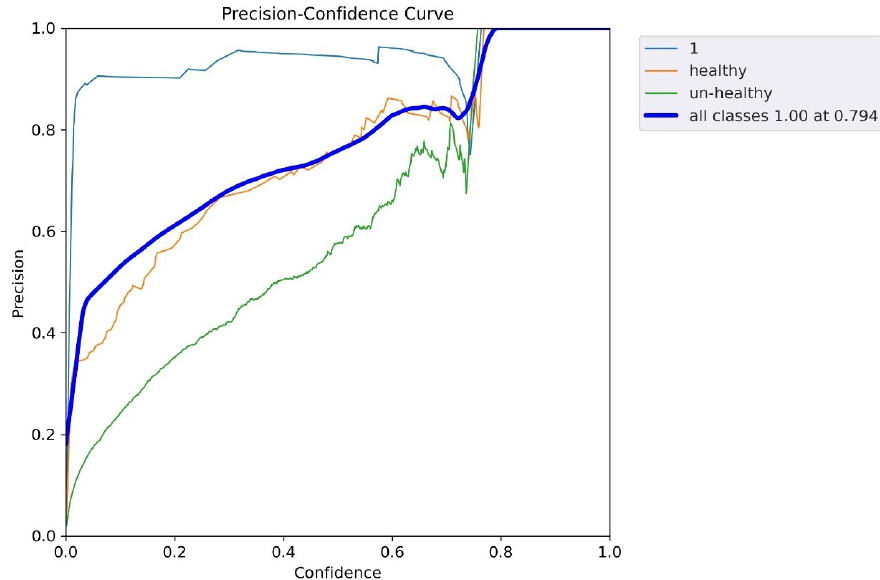
Figure 28. Confidence according to P curve graph: Comparison of the progression of precision across all experiments, grouped by training mechanism.